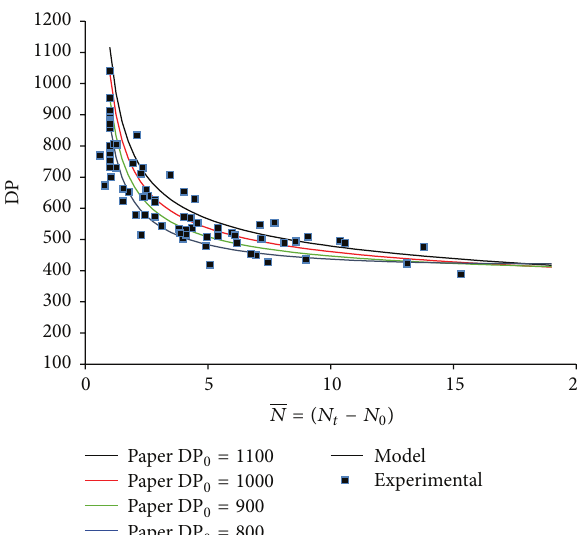
Figure 4: Experimental data of DP versus 𝑁 and model according to (3).